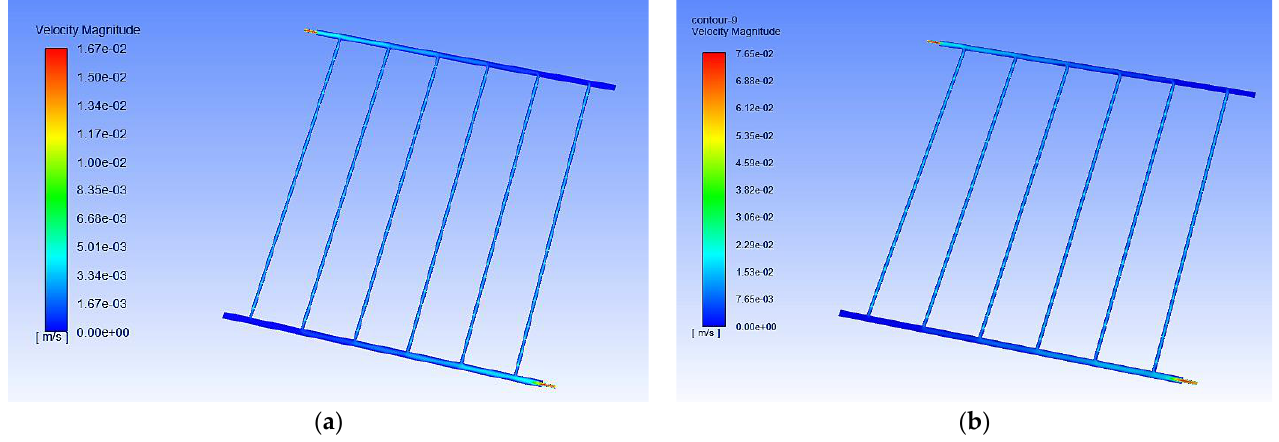
Figure 4. ( a ) Low mass flow rate with low velocity; ( b ) high mass flow rate with high